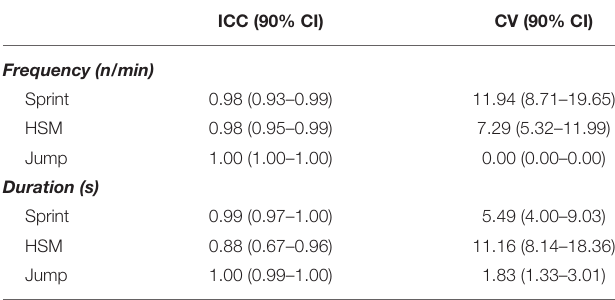
TABLE 1 | Intratester reliability of time-motion analysis